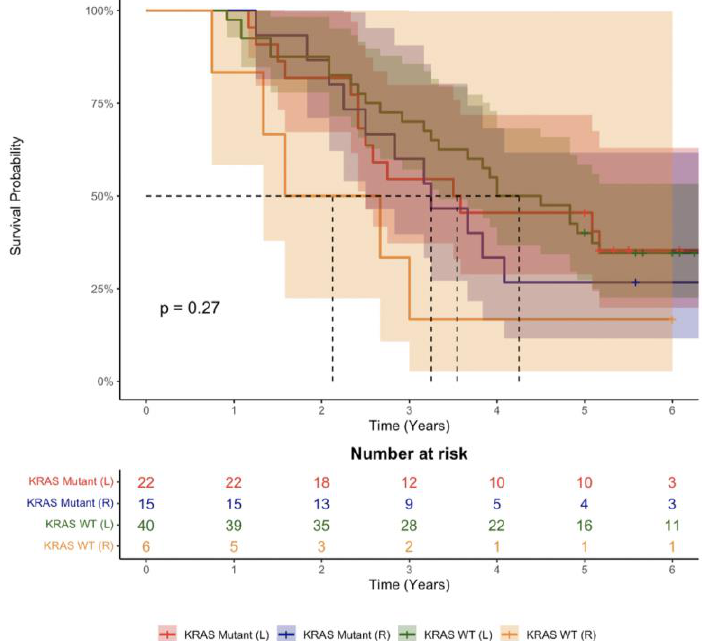
Figure 3. Kaplan–Meier of combined KRAS mutation status and sidedness. Data are presented as Figure 3. Kaplan – Meier of combined KRAS mutation status and sidedness. Data are presented as median with 95% confidence median with 95% confidence interval.